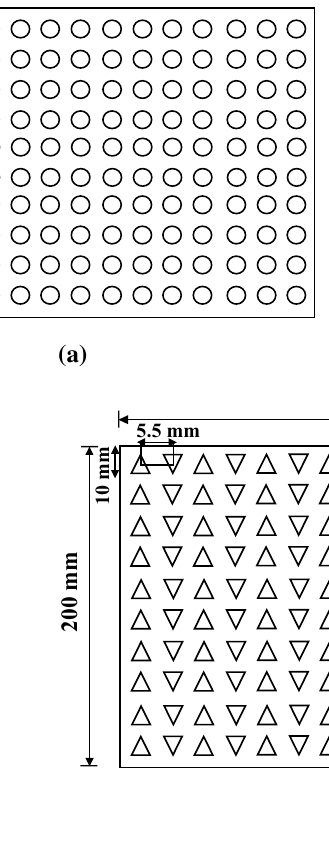
Fig. 3 Perforated screen with a circular, b square and c triangular shape openings